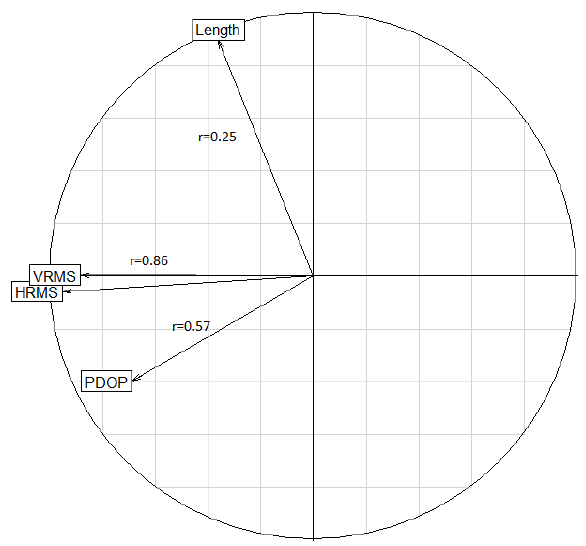
Figure 2: Projection of the quality variables of shape 1 in the first factorial plane 3.2.3 Horizontal error in static mode for landmarks: Table